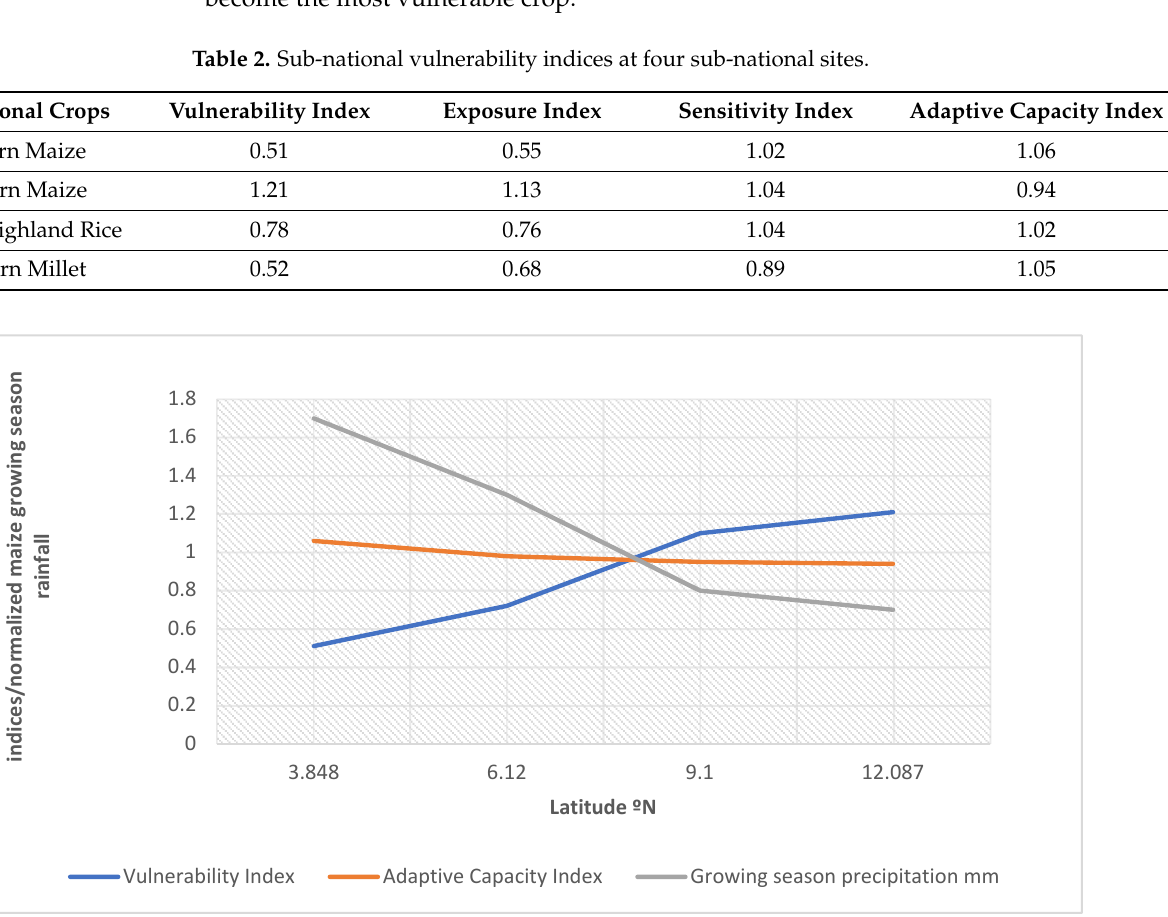
Figure 7. Latitudinal Variation in the Indices at the Sub-national Scale.